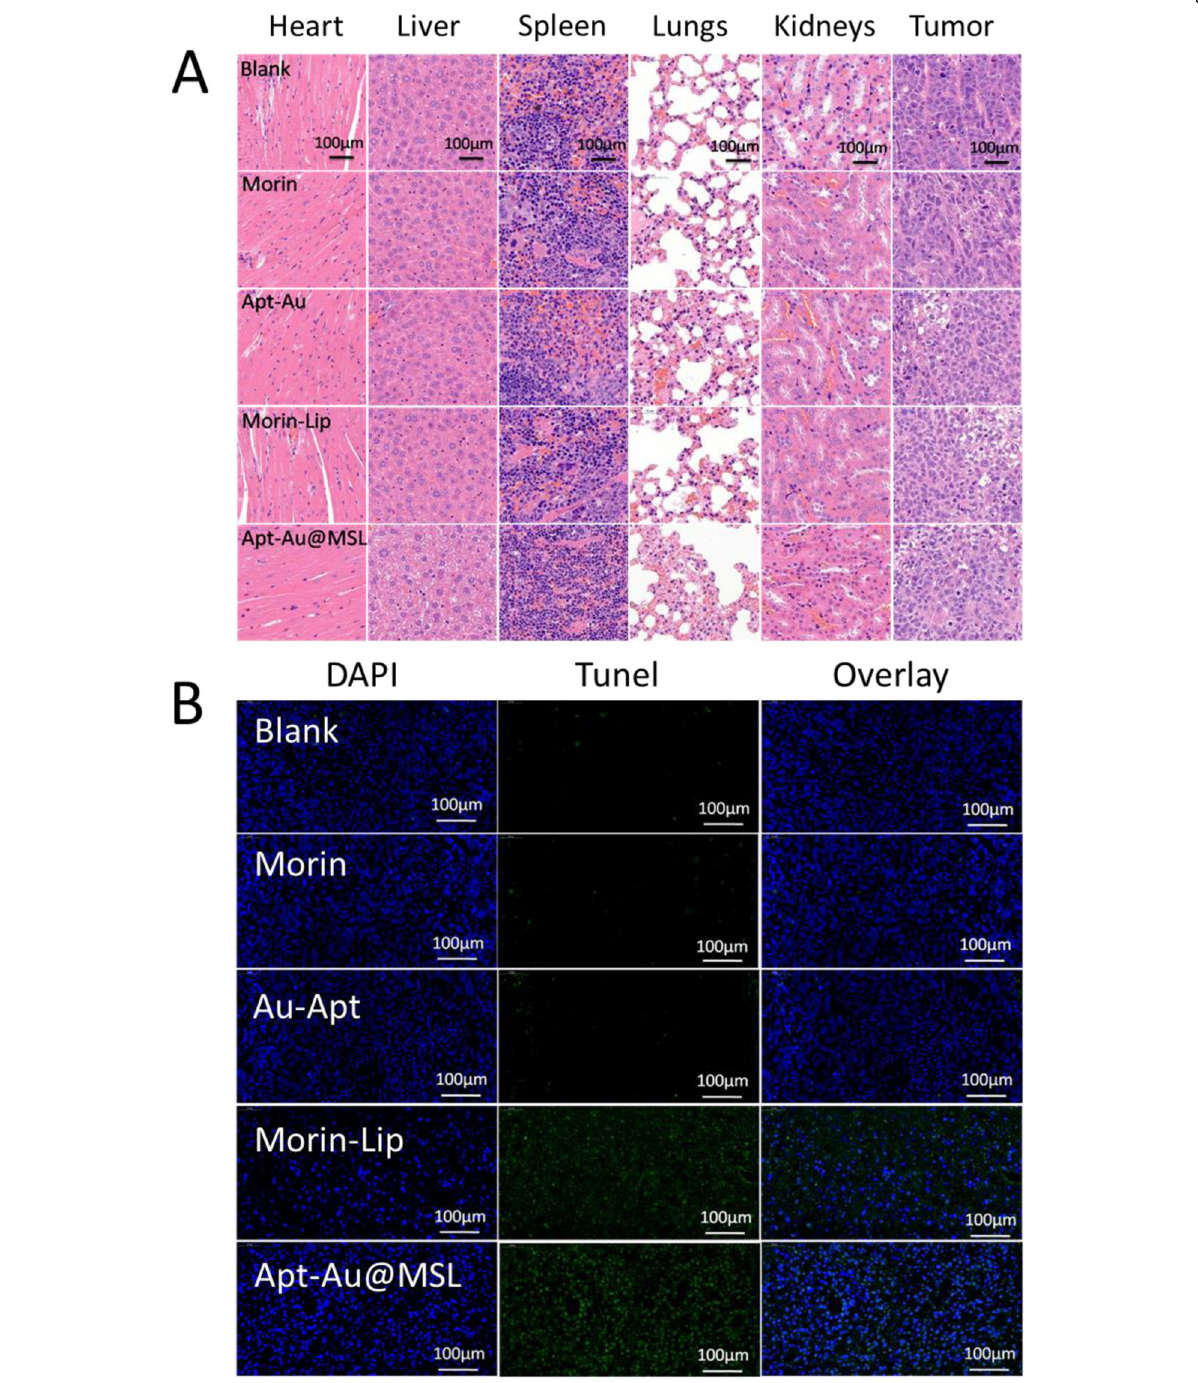
Fig. 10 a H&E staining analysis of the tumors in mice. Histological analysis of the tumors in mice following different treatments as PBS, Morin, Morin – liposome, Au-Apt, and Apt-Au@MSL group. b Apoptotic cells were detected by a TUNEL assay (green) and co-stained by nuclear staining DAPI